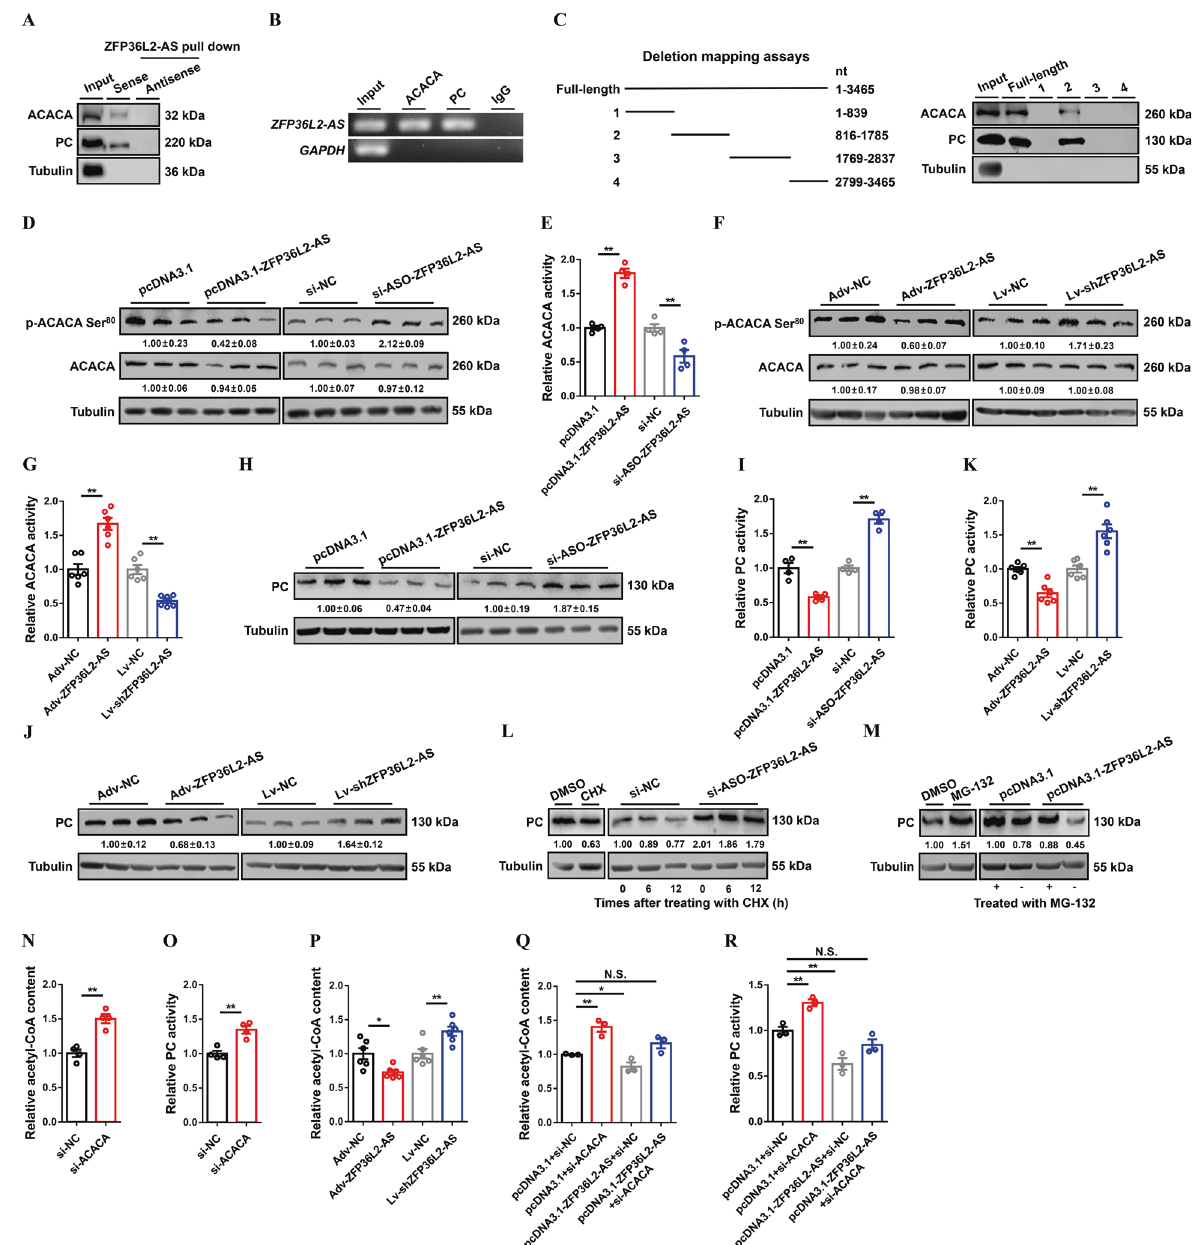
Fig. 6 lncRNA ZFP36L2-AS interacts with ACACA and PC to induce ACACA dephosphorylation and inhibit PC protein stabilization. A , B lncRNA ZFP36L2-AS interacts with ACACA and PC protein were determined by biotin-labeled RNA pulldown ( A ) and RIP ( B ). C The interaction of full-length and truncated ZFP36L2-AS with ACACA and PC protein was determined by RNA pulldown. D – G The protein expression levels of ACACA and phosphorylated ACACA ( D , F ), and relative ACACA activity ( E and G ) after ZFP36L2-AS overexpression or knockdown in vitro and in vivo. H – K The protein expression level of PC ( H , J ), and relative PC activity ( I , K ) after ZFP36L2-AS overexpression or knockdown in vitro and in vivo. ( L ) The protein expression level of PC in ZFP36L2-AS overexpressed myoblast was analyzed after incubated with the protein synthesis inhibitor cycloheximide (CHX; 25 µg/ml). ( M ) The protein expression level of PC in ZFP36L2-AS knockdowned myoblast was analyzed after incubated with the proteasome inhibitor (MG-132; 5 µmol/L) for 12 h. N , O Relative acetyl-CoA content ( N ), and relative PC activity ( O ) with ACACA interference in vitro. P Relative acetyl-CoA content with ZFP36L2-AS overexpression or knockdown in vivo. Q , R Relative acetyl-CoA content ( Q ), and relative PC activity ( R ) induced by the listed nucleic acids. In panels ( D , F , H , J , L , and M ), the numbers shown below the bands were folds of band intensities relative to control. Band intensities were quanti fi ed by ImageJ and normalized to β -Tubulin. Data are expressed as a fold-change relative to the control. Results are presented as mean ± SEM. In panels ( E , G , I , K and N – P ), statistical signi fi cance of differences between means was assessed using independent sample t -test. In panels ( Q , R ), ANOVA followed by Dunnett ’ s test was used. (* P < 0.05; ** P < 0.01; N.S., no signi fi cant difference).